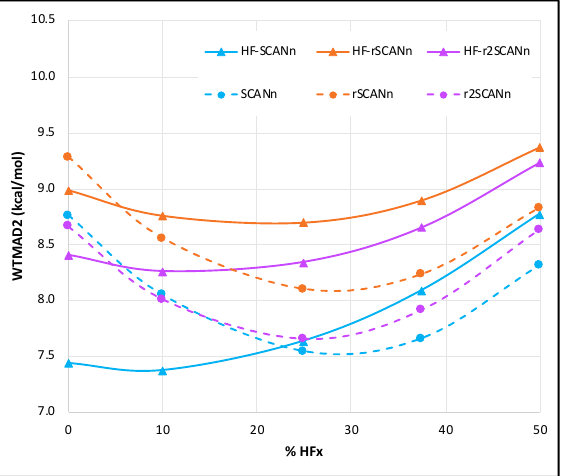
Figure 1. WTMAD2 (kcal/mol) trend with respect to the percentage of HF-like exchange (n) for self-consistent and HF-DFT forms of SCAN, rSCAN, and r 2 SCAN. The solid lines represent the HF-DFTs, and the dashed lines are for the corresponding self-consistent series.